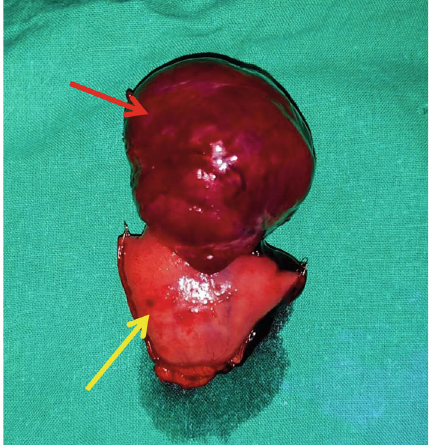
Figure 2: Coronal view of contrast-enhanced CT scan image arterial phase: yellow arrow shows the jejunal lesion; red arrow shows the contrast enhancement of superior mesenteric vein.